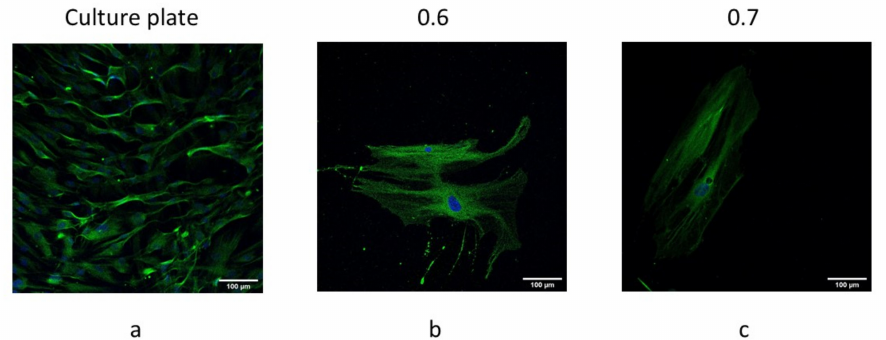
Figure 7. Osteocalcin detection by immunofluorescence in hBM-MSCs (at day 21) cultured on ( a ) conventional culture conditions, steel-filled PLA scaffolds of ( b ) 0.6 mm and ( c ) 0.7 mm line spacing. Osteocalcin (green) and nucleus (blue). Scale bars correspond to 100 µ